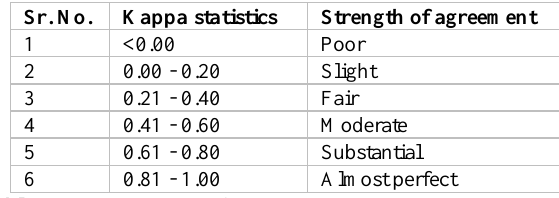
Table 2. Rating Criteria Of Kappa